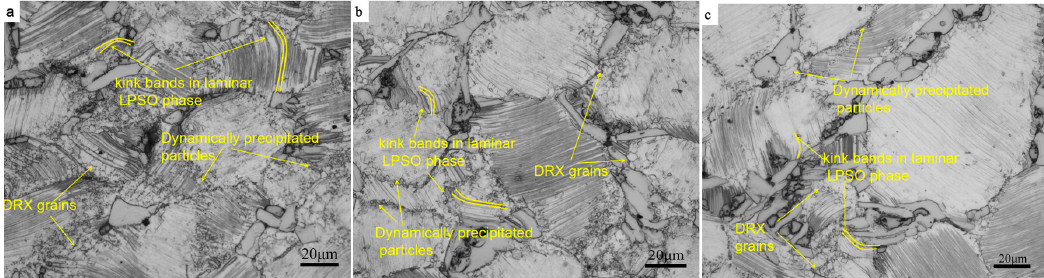
Figure 10. Microstructure of di ff erent regions at a strain rate of 0.1 s − 1 : ( a ) edge part; ( b ) middle part; ( c ) center